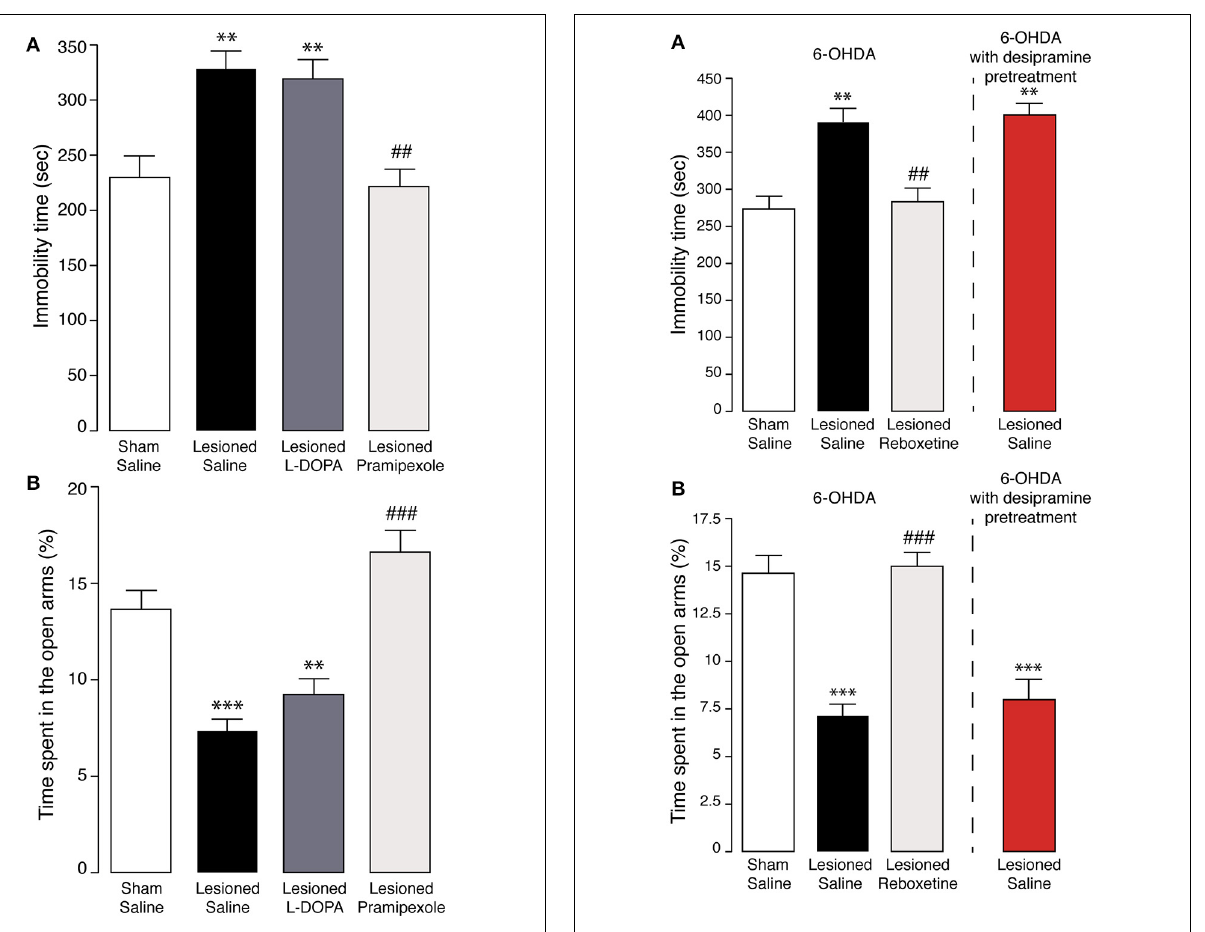
FIGURE 5 | Effect of L-DOPA and pramipexole on depression- and anxiety-like behaviors in 6-OHDA-lesioned mice. Sham, and 6-OHDA-lesioned mice treated for 4 days with saline, L-DOPA (10mg/kg), or pramipexole (0.6mg/kg) were tested in (A) the forced swim test, or (B) the elevated plus maze test. Bar graphs show the immobility time (s) during the forced swim test ( A ; test duration, 10min) and the time spent in the open arms (% of the test duration) during the elevated plus maze test ( B ; test duration 5min). Data are expressed as mean ± s.e.m. ( n = 4 − 7). ∗∗ p < 0 . 01 , ∗∗∗ p < 0 . 0001 vs. sham mice, ## p < 0 . 01 , ### p < 0 . 0001 vs.